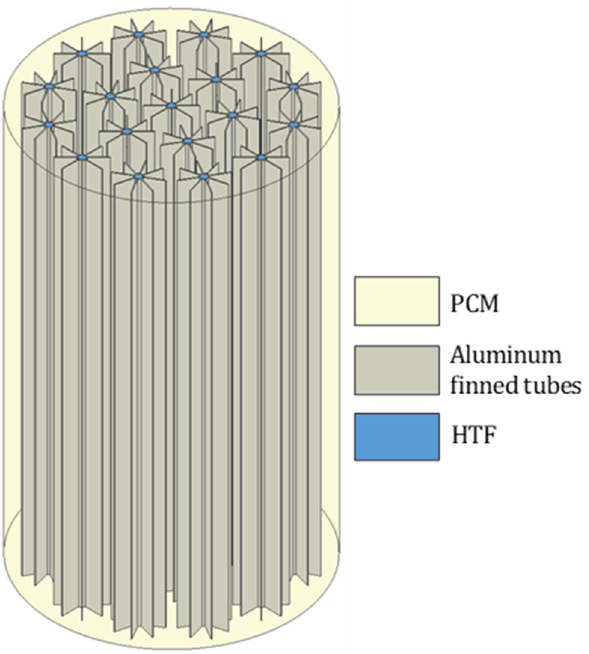
Figure 1. Schematic representation of analyzed shell and finned tube LTES tank.